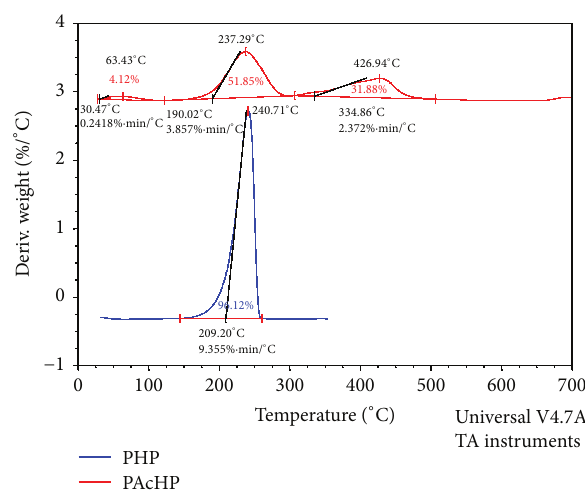
Figure 4: TGA curves of PHP (blue line, bottom) and PAcHP (red line, upper) obtained from bulk polymerization.